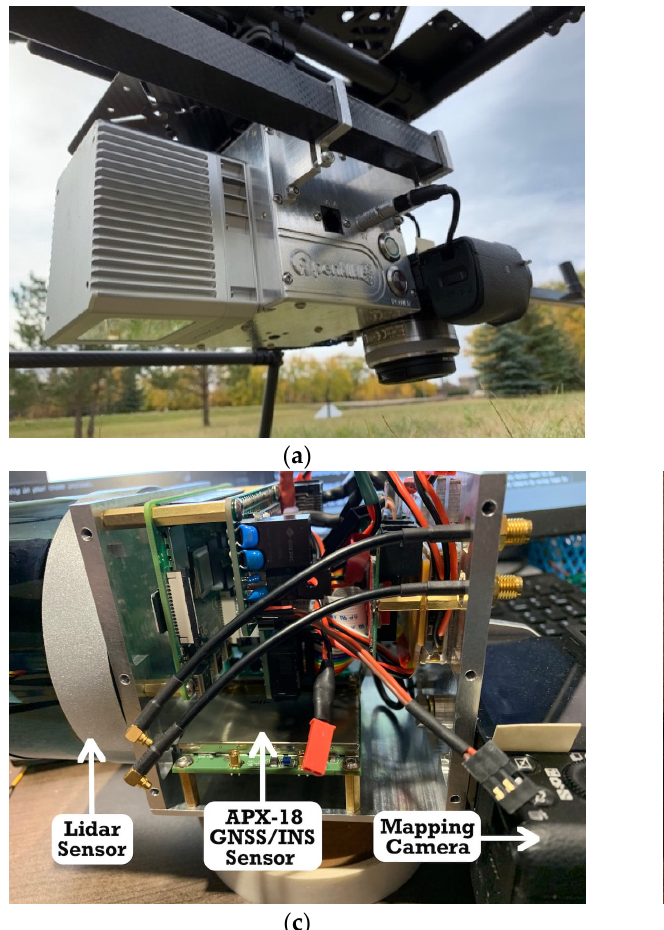
Table 3. Characteristics of each mission. Flight Name